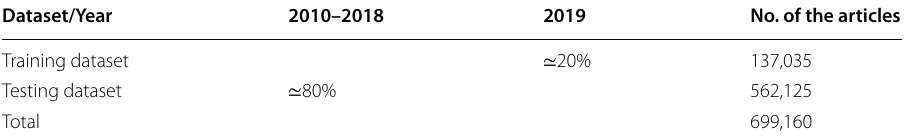
Table 2 train/test dataset percentage